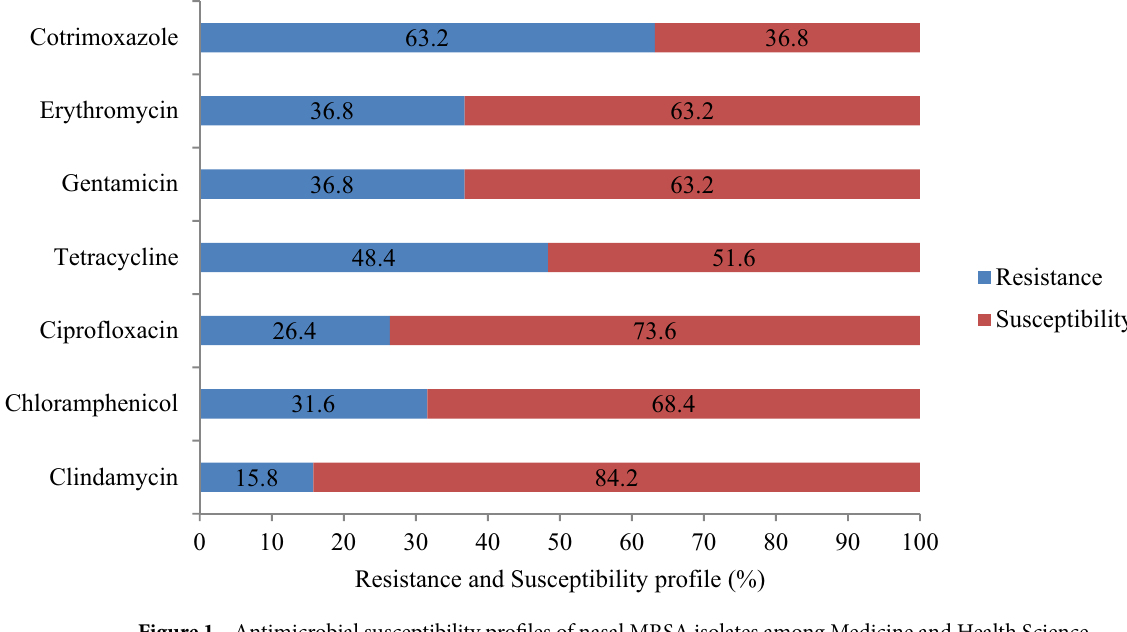
Figure 1. Antimicrobial susceptibility profiles of nasal MRSA isolates among Medicine and Health Science Students of Arba Minch University, Arba Minch, southern Ethiopia, 2020.